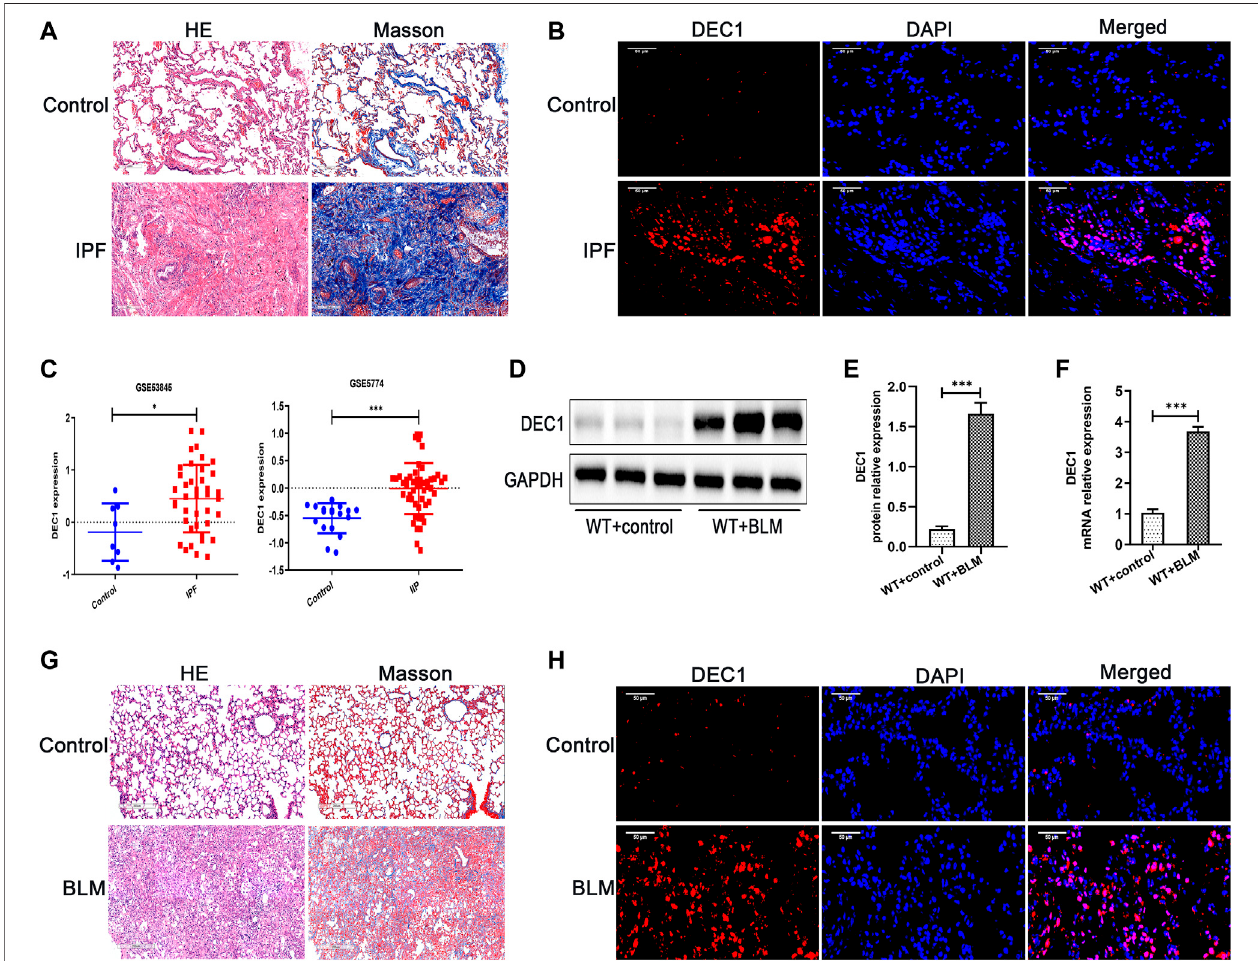
FIGURE1| DEC1isincreasedinIPFpatientsandBLM-stimulatedPFinmice. (A) RepresentativeHEstainingandMasson ’ strichromestainingoflungtissuesfrom normal people and IPF patients. Scale bar = 200 μ m n = 3. (B) Representative immuno fl uorescence staining of DEC1 (red) in the lung sections from normal people and IPFpatients.NucleiarestainedwithDAPI(blue).Scalebar=50 μ m n =3. (C) TheexpressionofDEC1inthelungtissuesfromhealthypeople,IPFpatientsandIIPpatients by analyzing GEO database. (D) The protein expression of DEC1 in the lung tissues were detected by western blotting. n = 6. (E) Statistical analysis of relative expression levels of proteins in (D) . (F) The mRNA expression of DEC1 in the lung tissues were measured by qRT-PCR. n = 6. (G) Representative HE staining and Masson ’ strichromestainingoflungtissuesinmice.Scalebar=200 μ m n =6. (H) Representativeimmuno fl uorescencestainingofDEC1(red)inthelungtissuesofmice. NucleiarestainedwithDAPI(blue).Scalebar=50 μ m n =6.Alldataareshownasthemean±SEM.Statisticalanalysiswasperformedbystudent ’ st-test.* p < 0.05,** p < 0.01, *** p < 0.001, ns p >